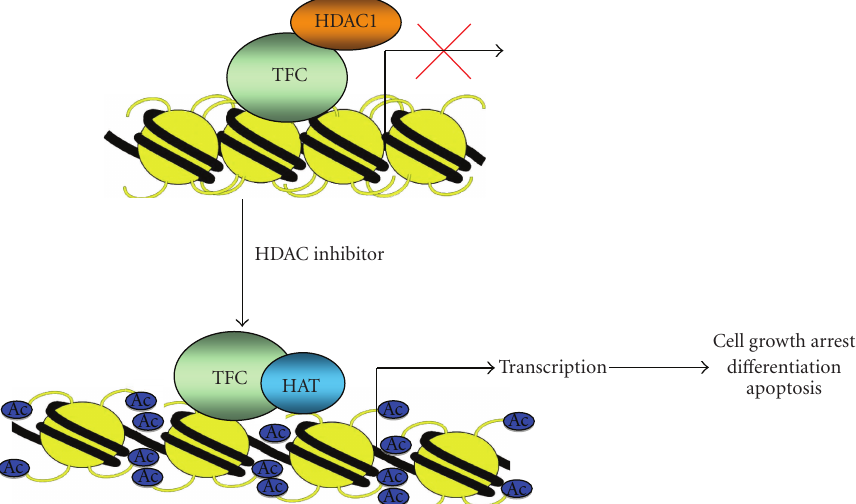
Figure 2: Mechanism of action of histone deacetylases inhibitors. It has been proposed that there are specific sites in the promoter region of a subset of genes that recruit the transcription factor complex (TFC) with histone deacetylases (HDACs). With inhibition of HDACs by HDACs inhibitors, histonesare acetylated, and the DNA that is tightly wrapped around a deacetylated histone core relaxes. The accumulation of acetylated histones in nucleosomes leads to increased transcription of this subset of genes, which, in turn leads to downstream e ff ects that result in cell-growth arrest, di ff erentiation, and/or